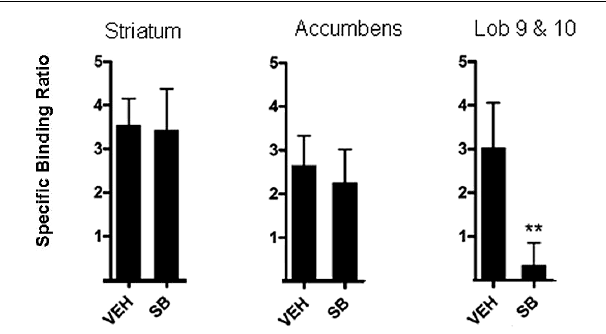
FIGURE 2 | In vivo method for occupancy of D3 in rats. [ 3 H]-( + )-PHNO specific binding ratio in dorsal striatum, nucleus accumbens, and cerebellar lobules 9 and10 (Lob 9 & 10) after pretreatment with vehicle (veh) or the selective D3 antagonist SB-277011-A (SB). Graphs depict mean ± SD. ** p < 0.01 compared to the vehicle-treated group. Adapted from McCormick etal.